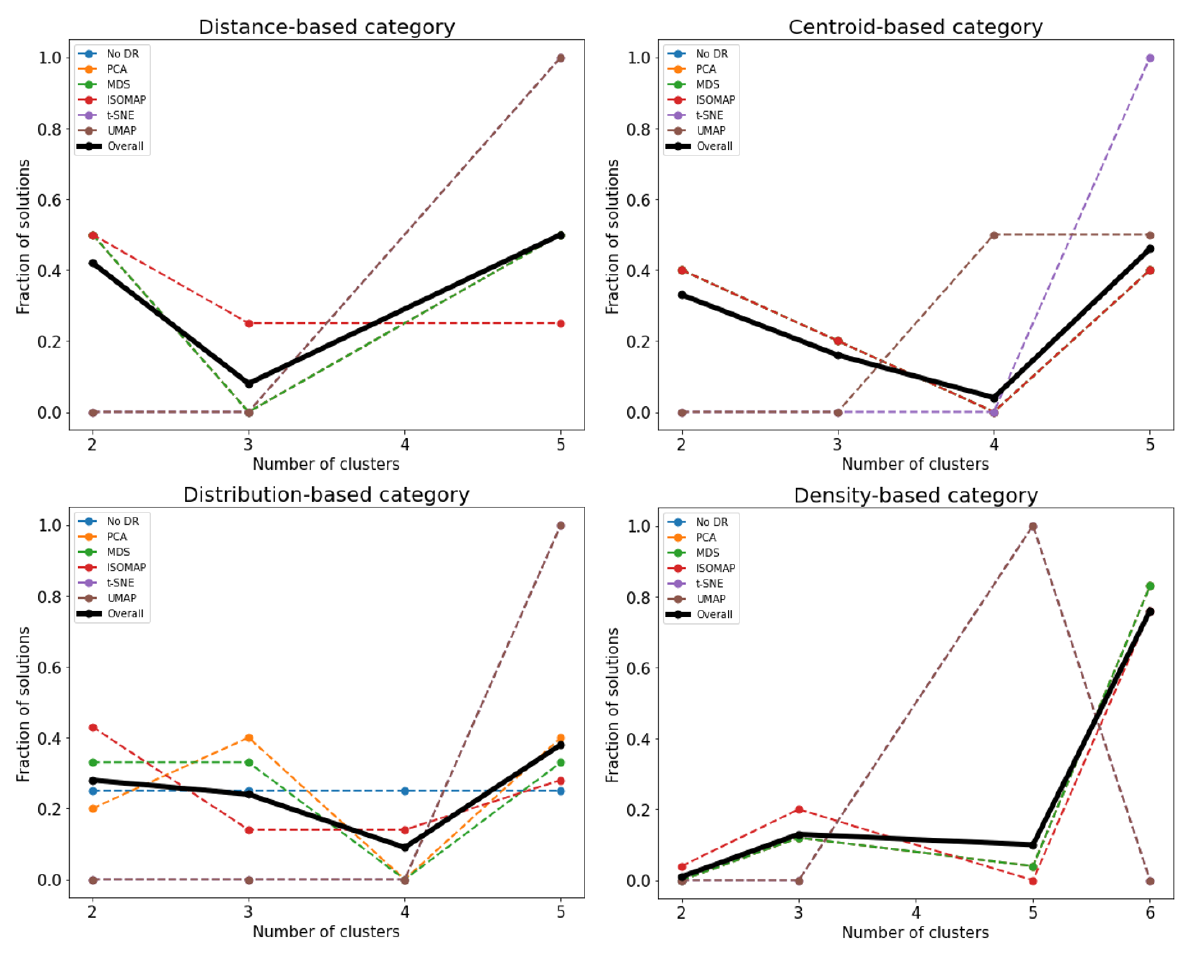
Figure 6. Fraction of solutions representing the found number of clusters in the synthetic data set for each DR technique.